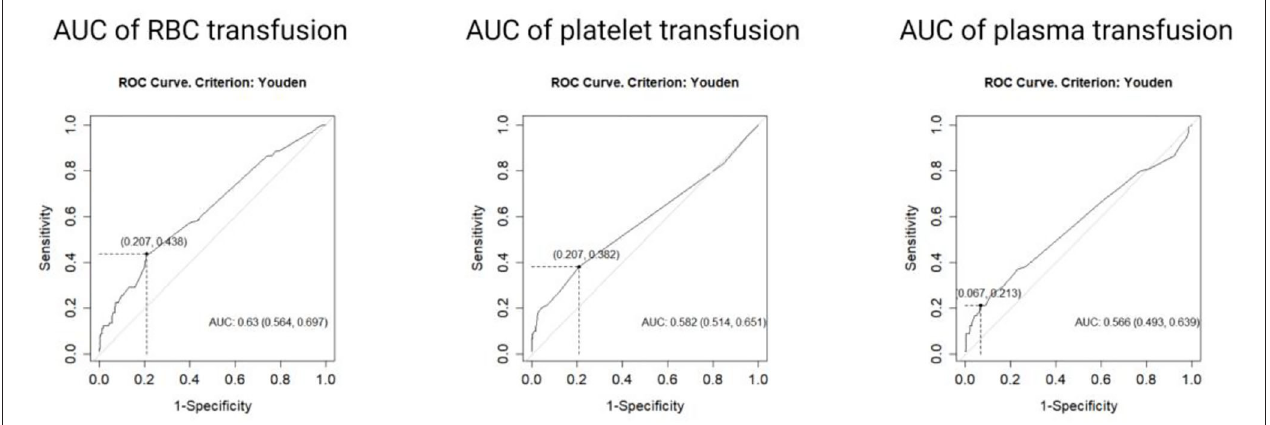
FIGURE 2 | Receiver operating curves analysis was performed on the whole population. According to Youden index, the transfusion cut-off values of three blood components were 9 units for red blood cell (AUC = 0.63, 95%CI 0.564, 0.697), 2 packages for platelet (AUC = 0.582, 95% CI 0.514, 0.651), and 1,250ml for plasma (AUC = 0.566, 95% CI 0.493,